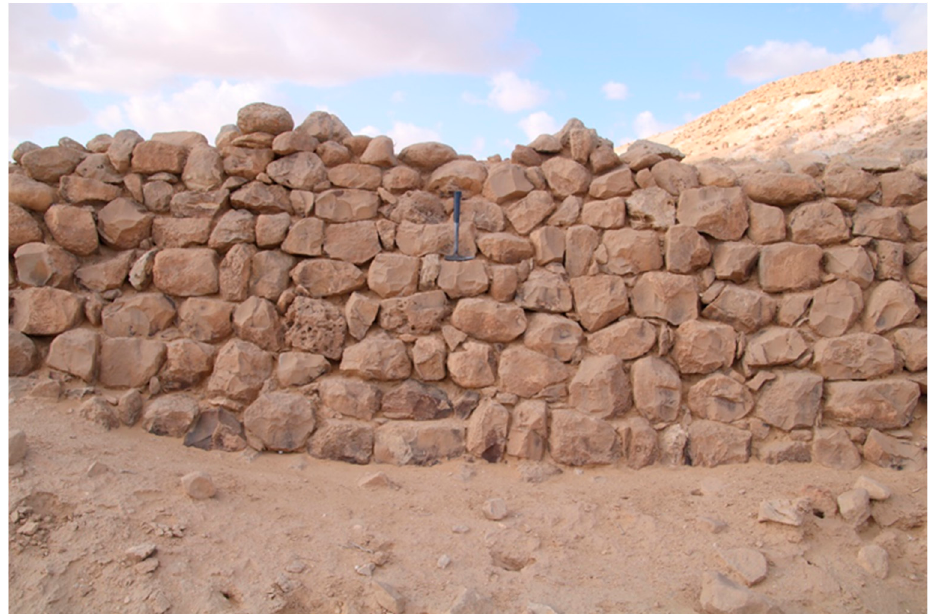
Figure 9. Type B agricultural terrace in the Negev Highlands. Note the collection of building stones used for the construction, composed of limestone and chert collected and quarried slabs. The une- ven collection of stones in the middle can hint at occasional collapse and restoration during the cultivation time. (Photograph: Y. Avni).